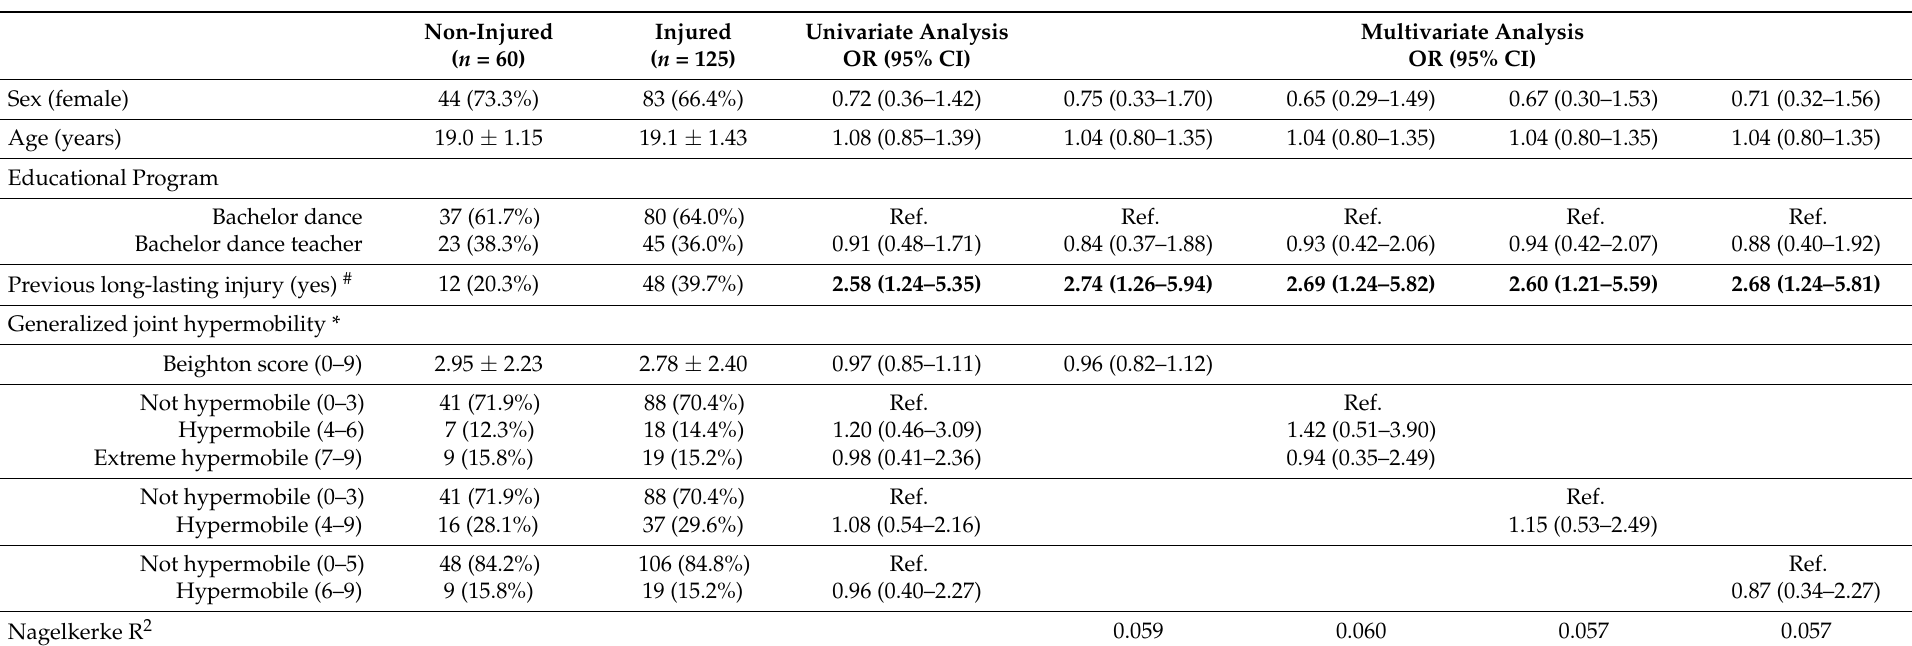
Table 2. Univariate and multivariate models of potential risk factors for all complaints